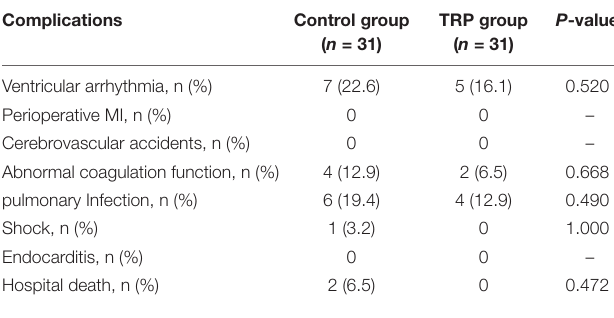
TABLE 5 | Postoperative